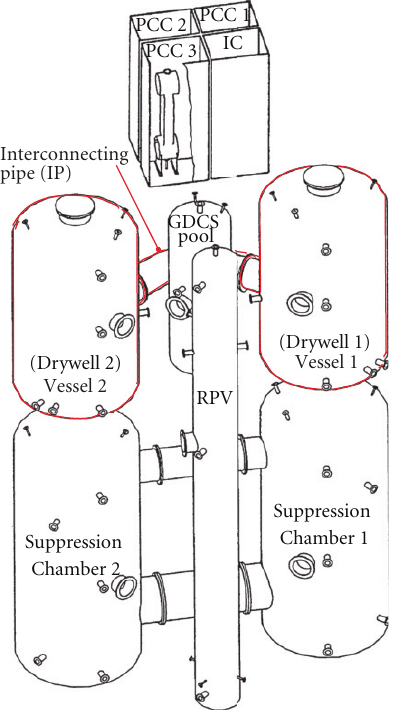
Figure 1: Schematic of the PANDA facility.